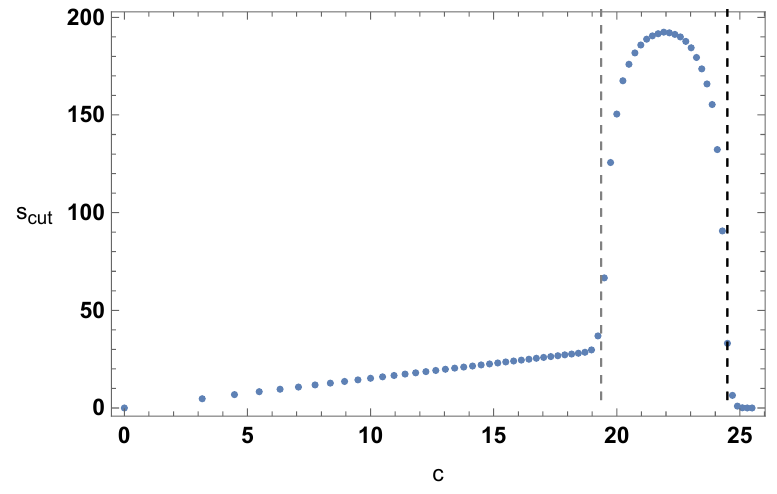
Figure 6 . The behavior of the entanglement entropy, s cut , (unnormalized) as the lengthscale of the square cut increases for N = 600 . The dashed gray vertical line in this figure corresponds to the transition at the solid grey line in figure 5, and the dashed black vertical line corresponds to the solid black line where the cut leaves the